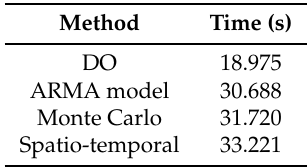
Table 8. The computation time of the methods.